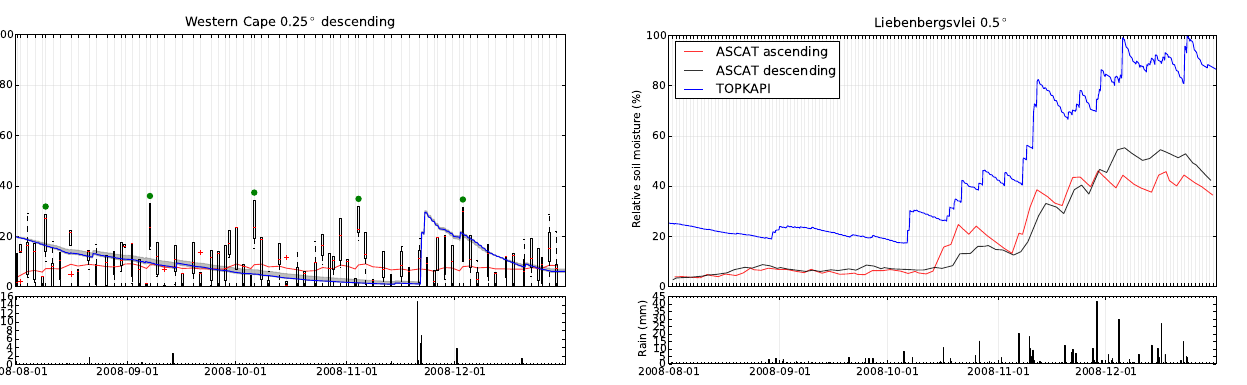
Fig. 12. Site A – Western Cape. TOPKAPI and ASCAT derived soil wetness, and TRMM 3B42RT 3h accumulated rainfall. The top panel shows the median TOPKAPI SSI averaged over a 0.25 ◦ block (blue line), with the inter-quartile range of these four esti- mates within the block shown by the grey fill. The range of ASCAT estimates (they number between 2 and 6 on a given day in a 0.25 ◦ square) within the box at each overpass time is shown by the box and whisker plots (for ascending and descending orbits), while the red line shows the filtered time series of the mean ASCAT estimates. The bottom panel shows a histogram of 3h rainfall accumulations. The sequence of green dots highlight a marked increase in the AS- CAT estimated soil moisture, which has a periodicity that matches the 29 day repeat cycle of METOP (Figa-Salda˜na et al., 2002). It is clear that the ASCAT SSM does not respond to the rainfall in November and is very noisy at this site.